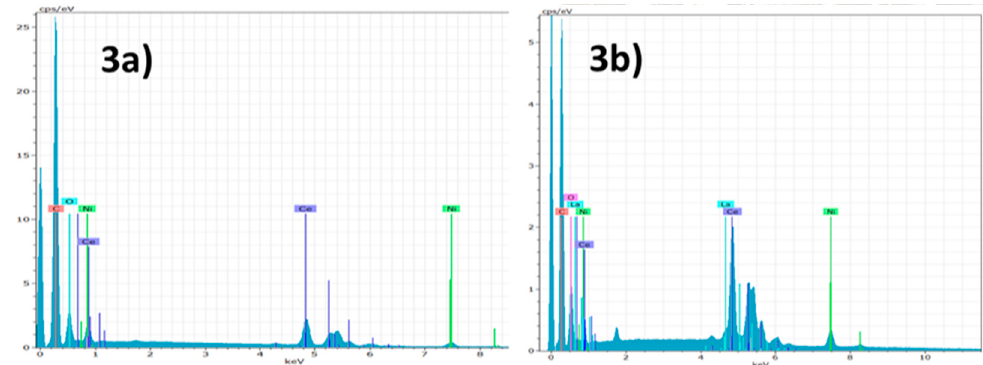
Figure 8. SEM and EDX analyses for Ni/Ce ( 1a , 2a , 3a ) and oNi/LaCe ( 1b , 2b , 3b ).